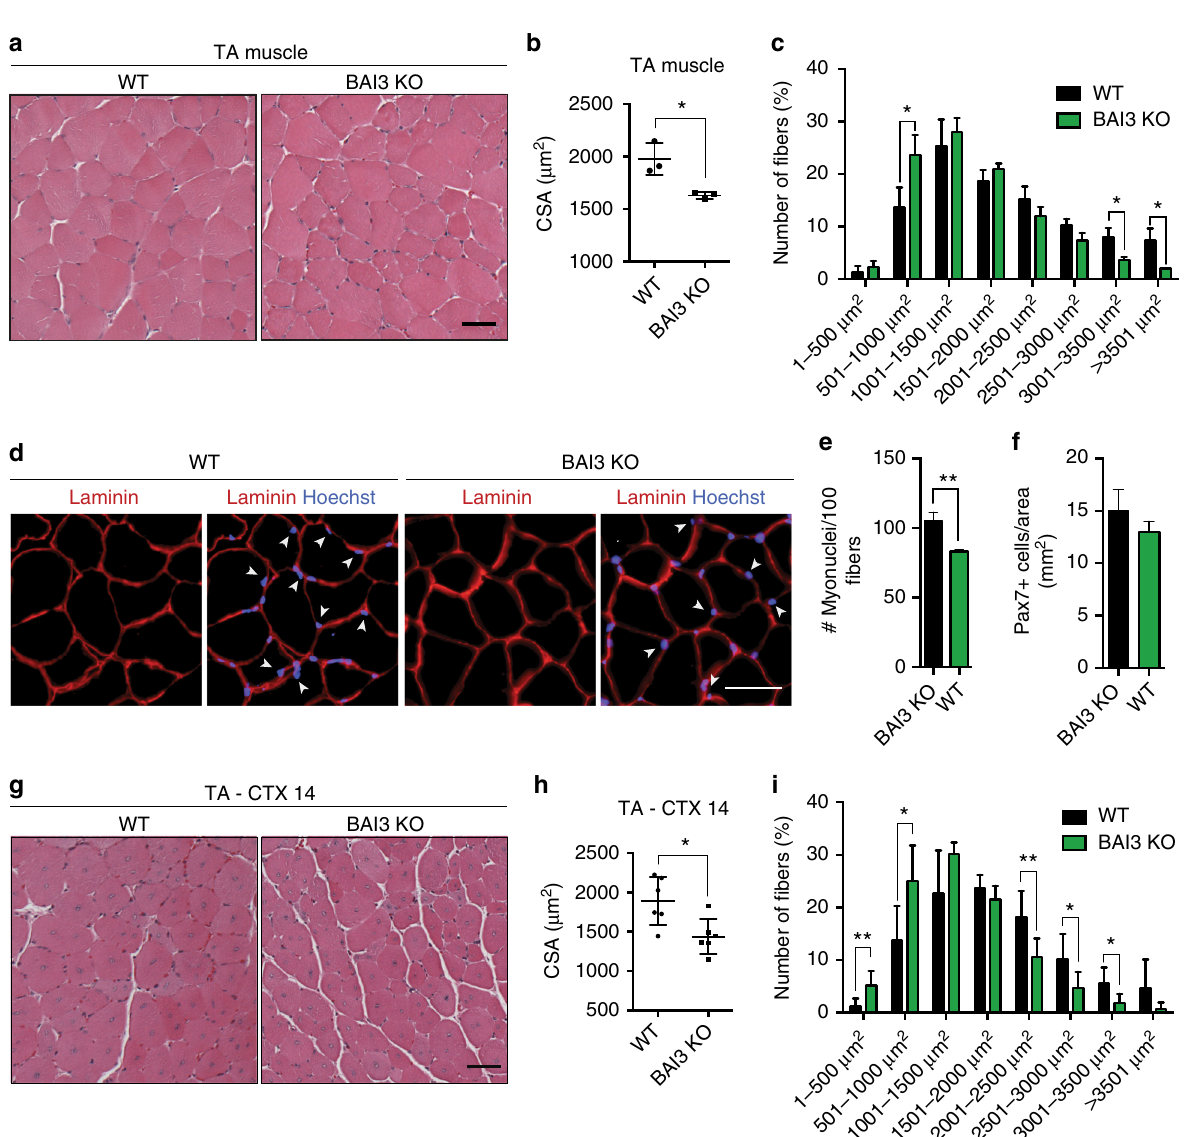
Fig. 1 BAI3 KO mice display smaller myo fi bers and a less ef fi cient muscle regeneration. a BAI3 KO adult mice display smaller myo fi bers than control animals. Representative H&E staining of the TA muscle section of BAI3 KO and WT mice. b Quanti fi cation of a showing the mean cross-sectional area (CSA) per mice ( n = 3 mice). c Distribution of myo fi bers size of a . d , e Myonuclei number per fi ber is reduced in BAI3 KO mice. d Cross-sectional muscle sections of BAI3 KO and control mice stained with anti-laminin (red) and Hoechst (blue). Arrowheads indicate myonuclei located inside the myo fi bers. e Quanti fi cation of the number of myonuclei located inside the myo fi bers of d ( n = 3 mice). f Quanti fi cation of Pax7-positive cells of cross-sectional muscle sections (BAI3 KO and WT mice) stained with anti-Pax7. g BAI3 KO adult mice display smaller myo fi bers following cardiotoxin-induced injury of the TA muscle after 14 days of regeneration (H&E staining). h Quanti fi cation of g showing the mean CSA per mice ( n = 6 mice). i Distribution of myo fi bers size of g . Error bars indicate standard deviation. Scale bar = 50 μ m. One-way ANOVA followed by a Bonferroni test was used to calculate the P values; * P < 0.05, ** P <